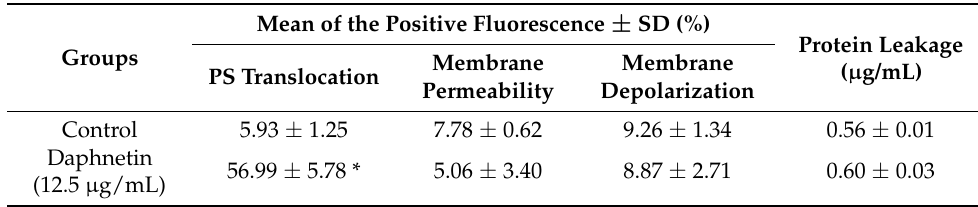
Table 2. Membrane changes induced by